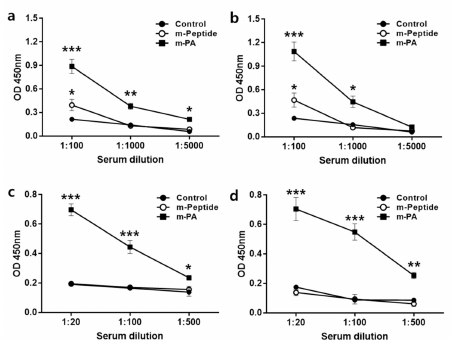
Figure 6. Humoral immune response induced by EV71 antigens (m-peptide, m-PA). The level of ( a ) rVP1, and ( b ) rVP3-specific immunoglobulin G (IgG) production was detected by using indirect enzyme-linked immunosorbent assay (ELISA). The level of ( c ) rVP1, and ( d ) rVP3-specific IgG1 was measured by ELISA. All data are presented as mean ± SEM. Significant di ff erence from the control group are indicated by * p < 0.05, ** p < 0.01, *** p < 0.001 ( n = 4).